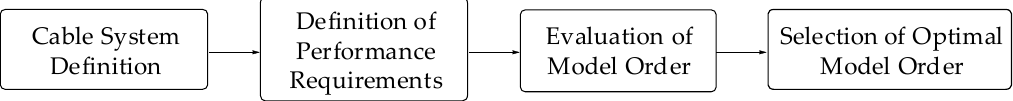
Figure 15. General procedure for the determination of the optimal order of the FDPi model.